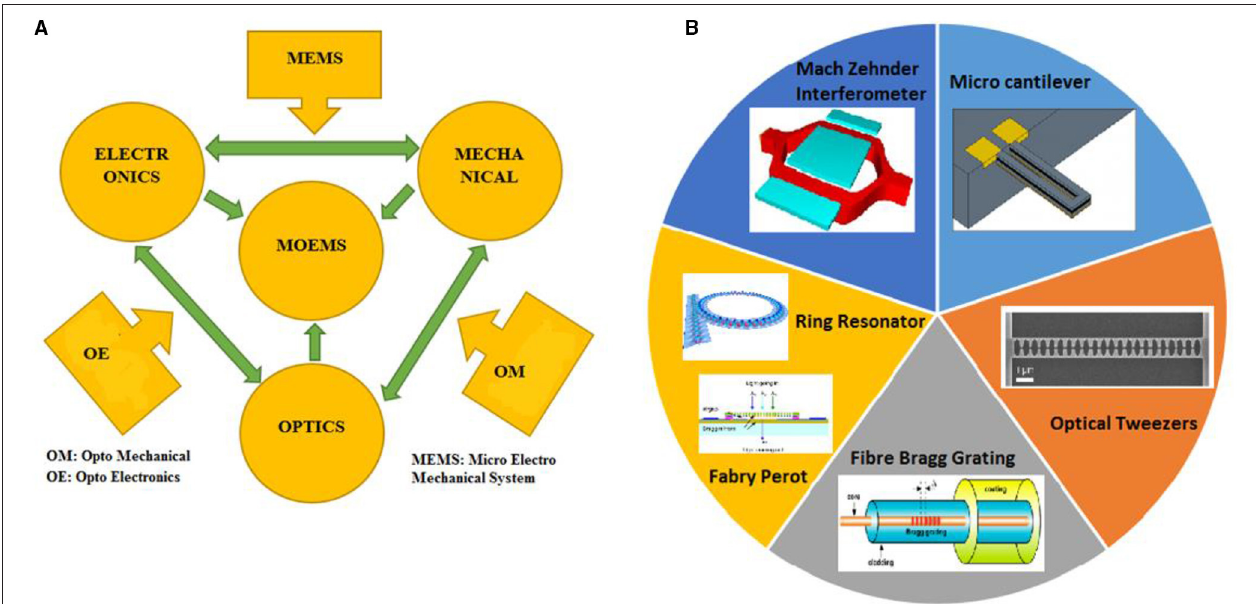
FIGURE 1 | (A) MOEMS overview chart, (B) different types of Optical MEMS.